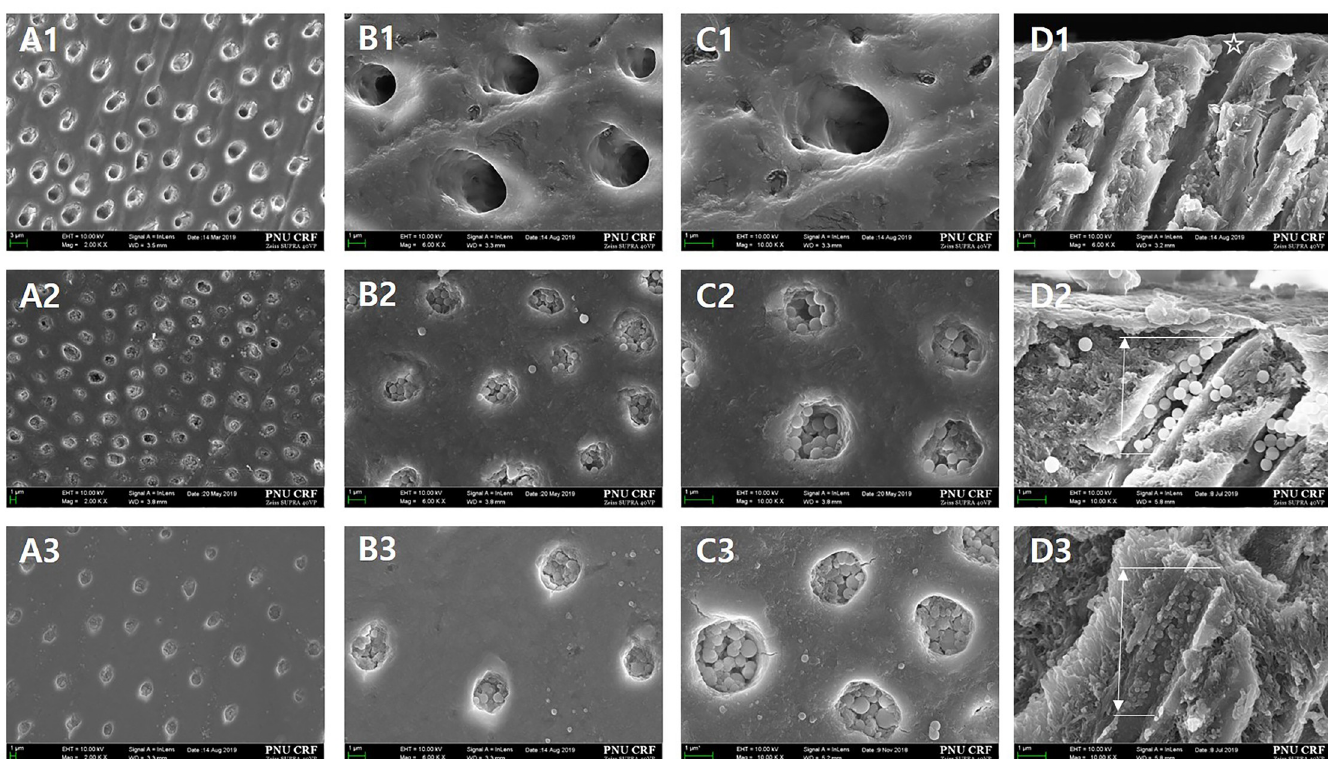
Fig 11. FESEM micrographs of the top and longitudinal sections of the hypersensitive tooth model to confirm the tubule-occluding effect in each group (A, x2,000; B, x6,000; C, x10,000; D, sagittal). There is no smear layer in the dentinal tubule in the A1–D1 images of Group 1 (control) ( � ). The image of Group 2 (Dense BGN) shows a partially occluded dentinal tubule at 4–5 μ m depth (arrow). The image of Group 3 (MBGN) shows a partially occluded dentinal tubule at 5–6 μ m depth (arrow).